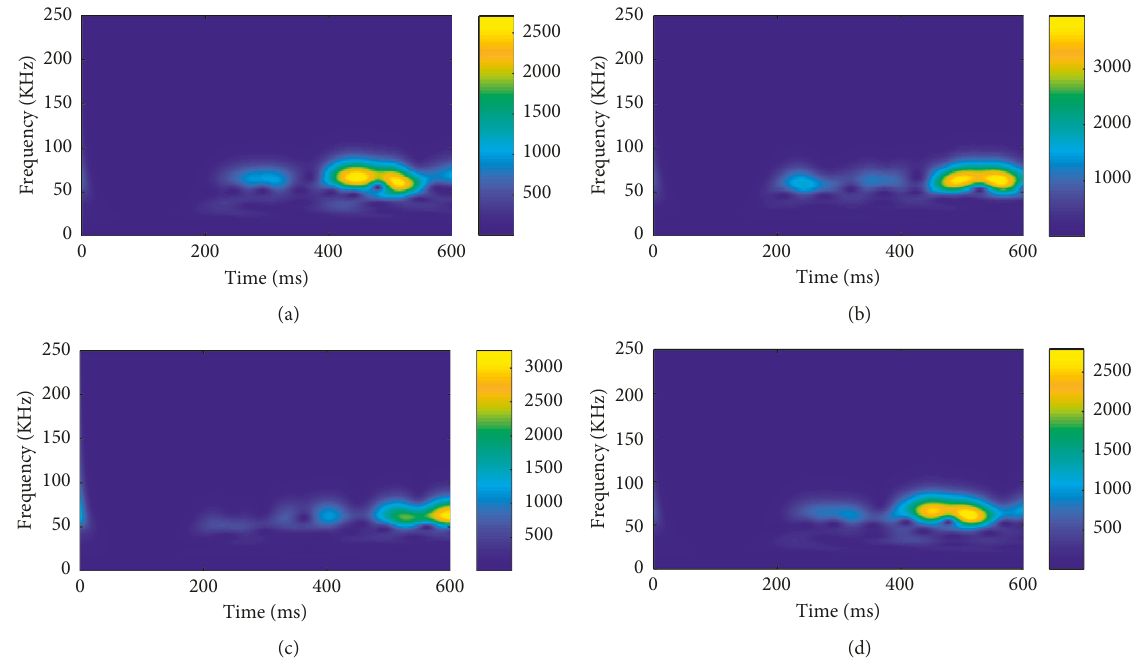
Figure 11: Energy spectrum of the S transform: (a) square hole depth 100mm; (b) square hole depth 200mm; (c) square hole depth 300mm; (d) square hole depth 400 mm.